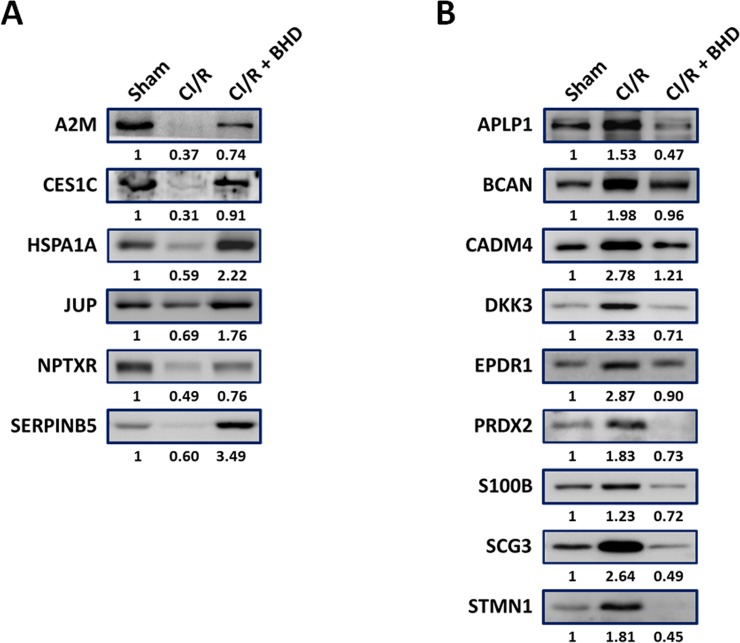
Validation of selected CSF proteins by Western blotting.(A-B) Mice were divided into three groups. One group served as untreated controls, one group had CI/R-induced stroke, and the other group was treated with CI/R and BHD. Mice were sacrificed and CSF was collected. The predicted markers were quantified followed by Western blot analysis.